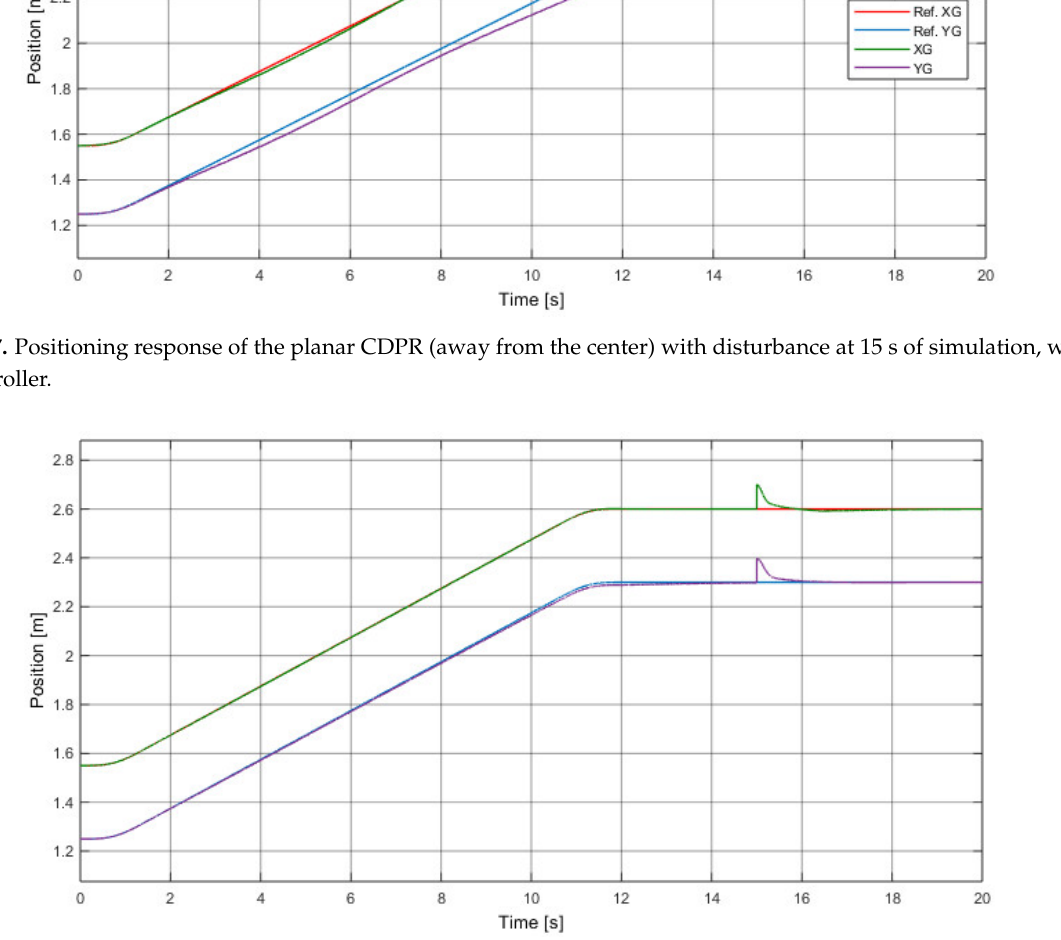
Figure 28. Positioning response of the planar CDPR (away from the center) with disturbance at 15 s of simulation, with a fuzzy PID controller.